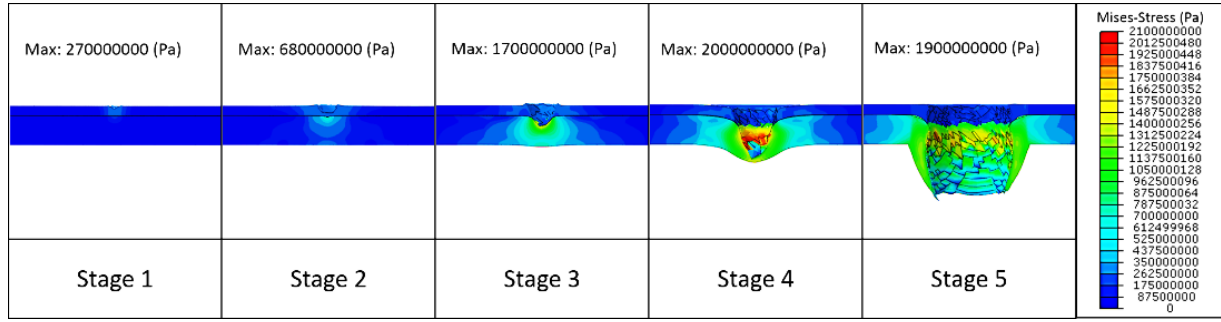
Figure 23. Equivalent thermal stress, or Von Mises stress, for friction drill joining of AISI304/Al6061, at different stages.